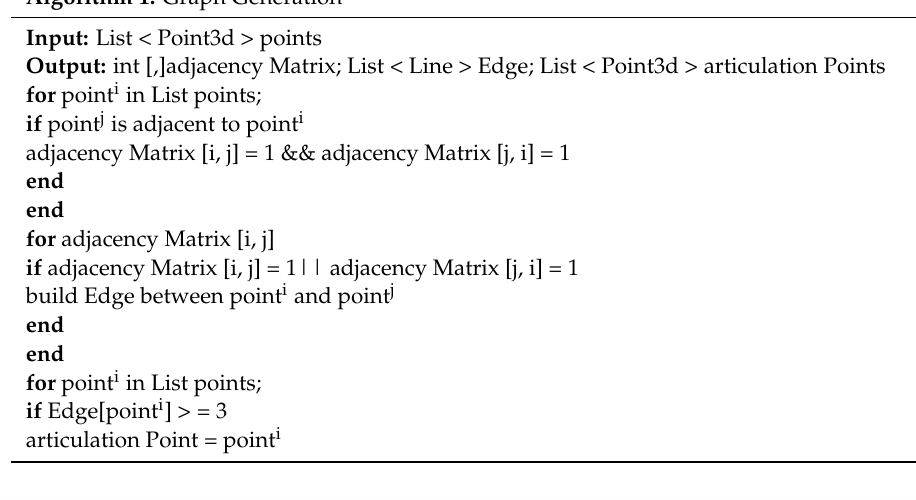
Algorithm 1. Graph Generation